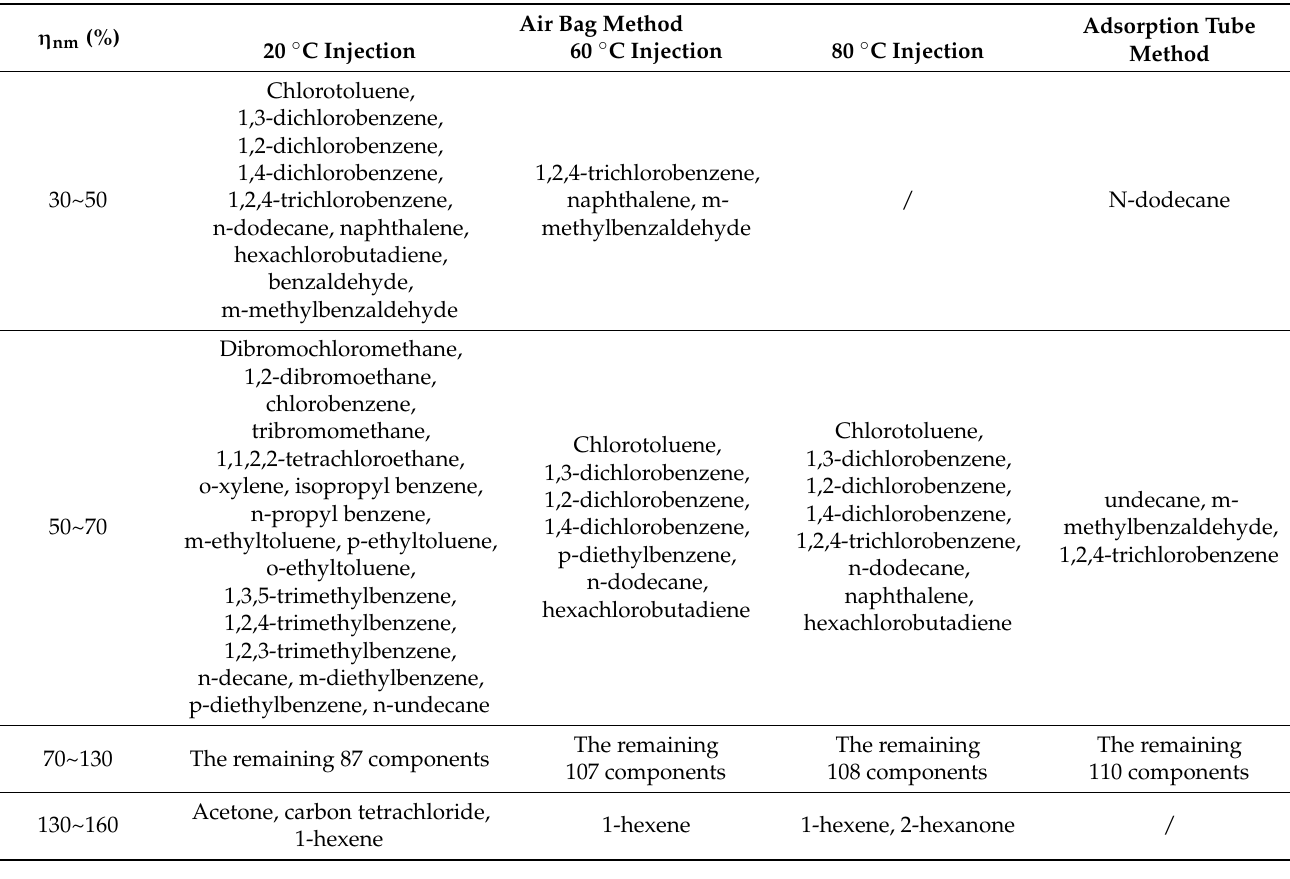
Table 2. The recovery percentage of standard samples of